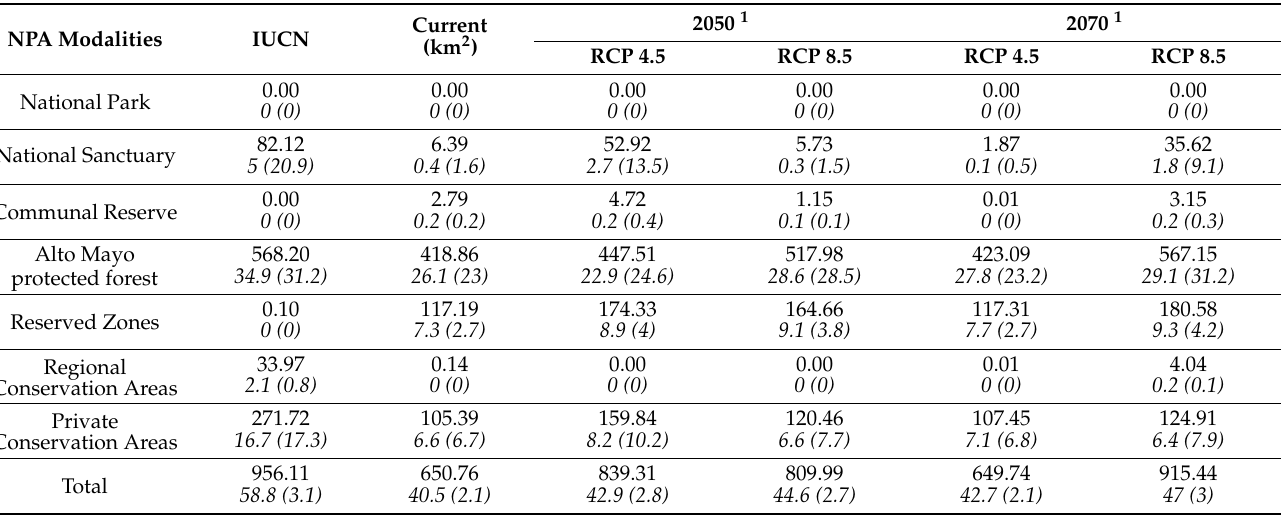
Table 4. Area (in km 2 and %) of the total predicted potential distribution under both current conditions and climate change scenarios of X. loweryi in natural protected area categories of Amazonas and San Martin